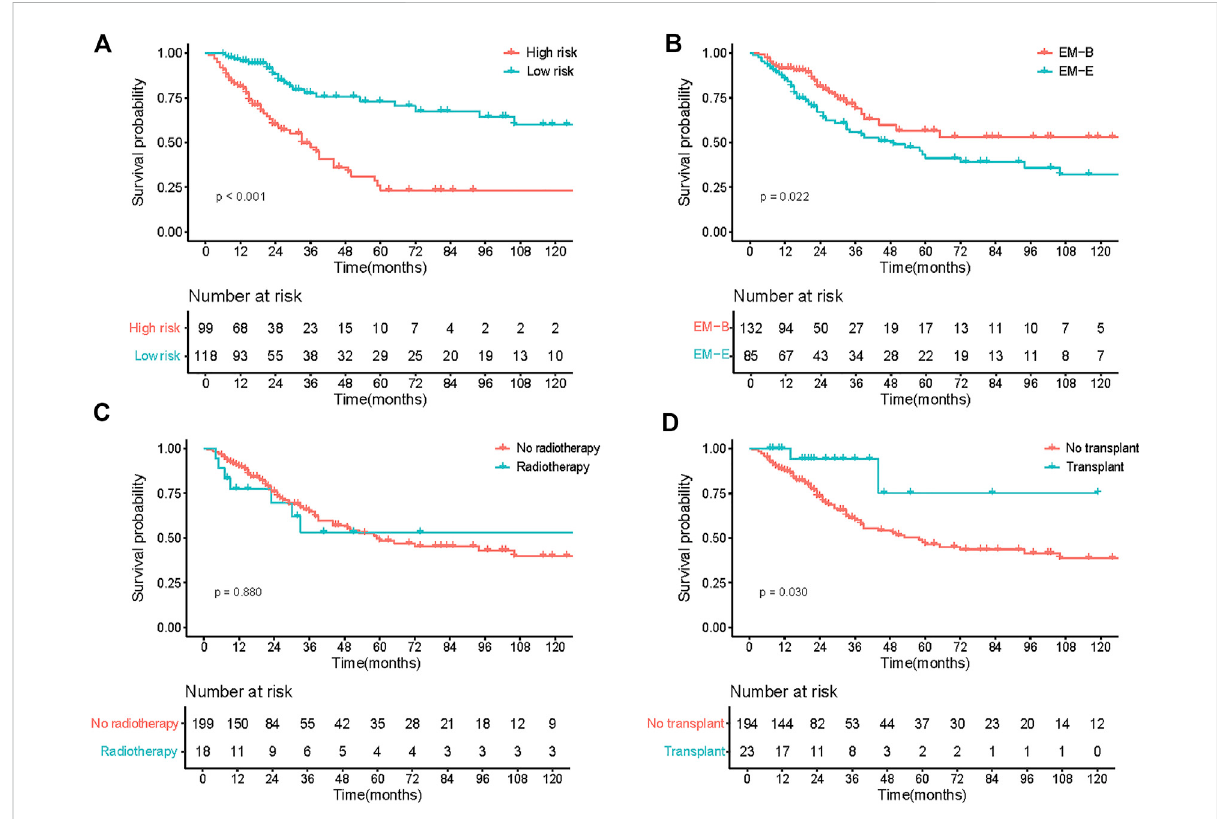
FIGURE 4 OS of patients according to different strati fi cation. (A) Survival curvesof risk strati fi cation based on our model (High risk vs Low risk). (B) Survival curvesofdifferentgroups(EM-BvsEM-E). (C) Survivalcurvesofdifferenttreatment(NoradiotherapyvsRadiotherapy). (D) Survivalcurvesofdifferent treatment (No transplant vs